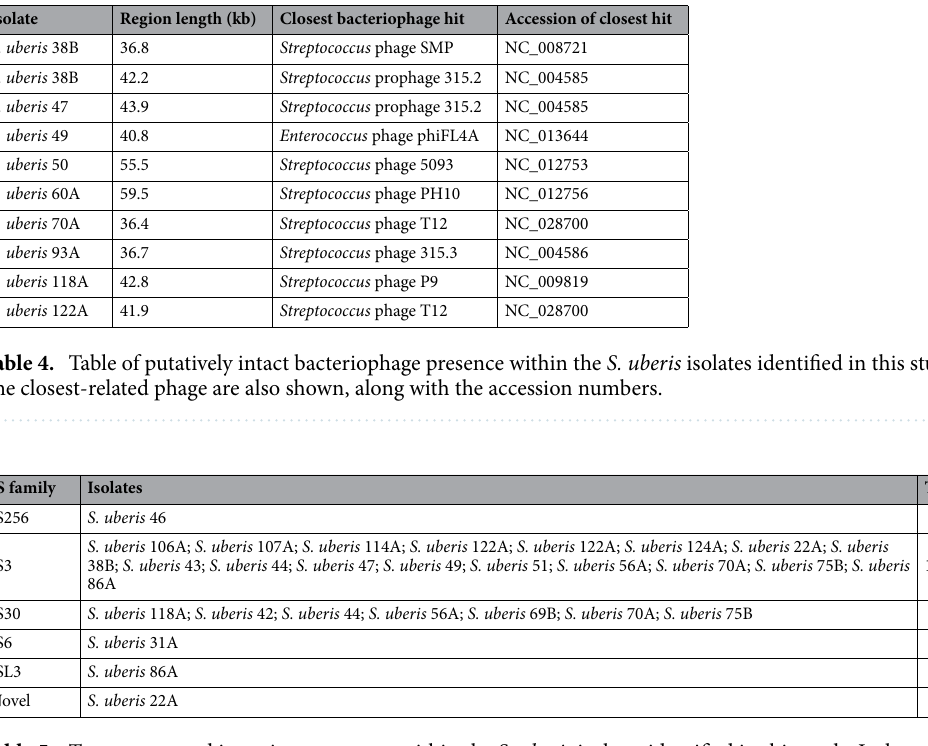
Table 5. Transposon and insertion sequences within the S. uberis isolates identified in this study. Isolates which contain IS families are separated by semicolons. S. uberis 122A contains two different IS3 regions and is included twice in this